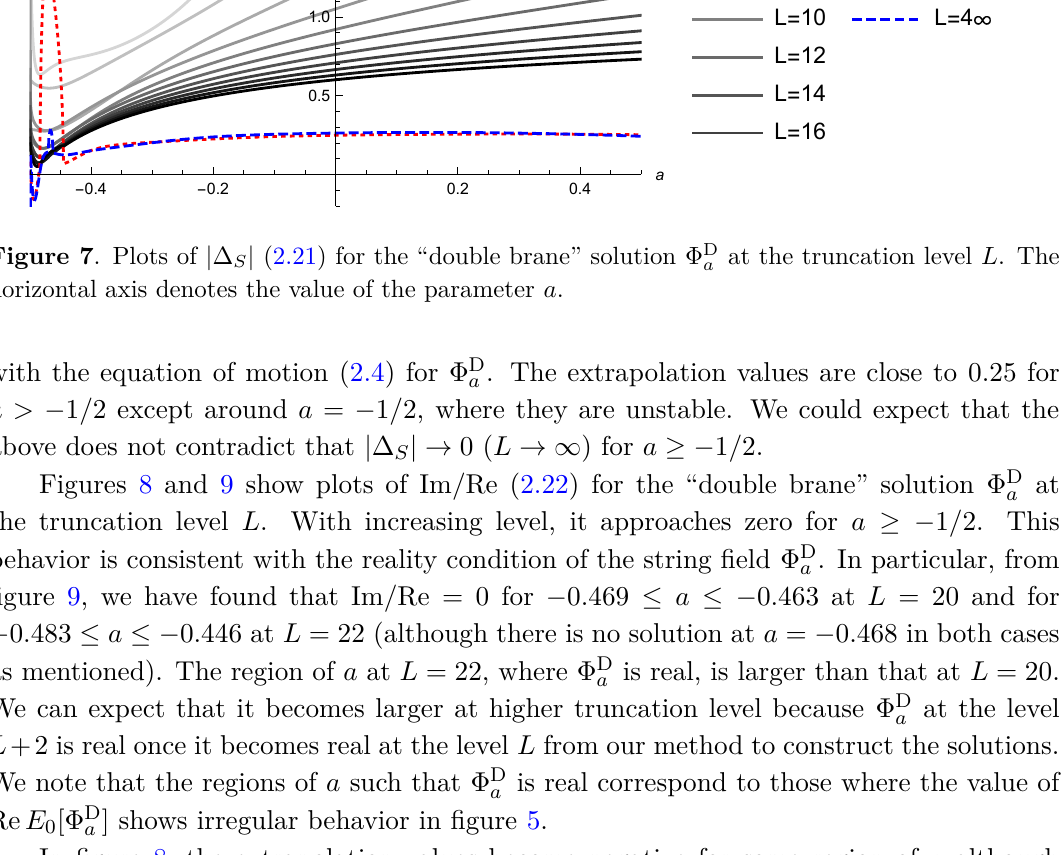
at the truncation level L . The a